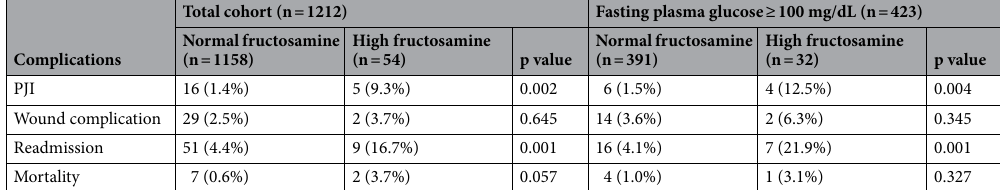
Table 2. Adverse outcomes in patients with high (≥ 293 µmol/L) and low (< 293 µmol/L) fructosamine levels in the entire cohort and in a subgroup who had glucose levels above 100 mg/dL. PJI periprosthetic joint